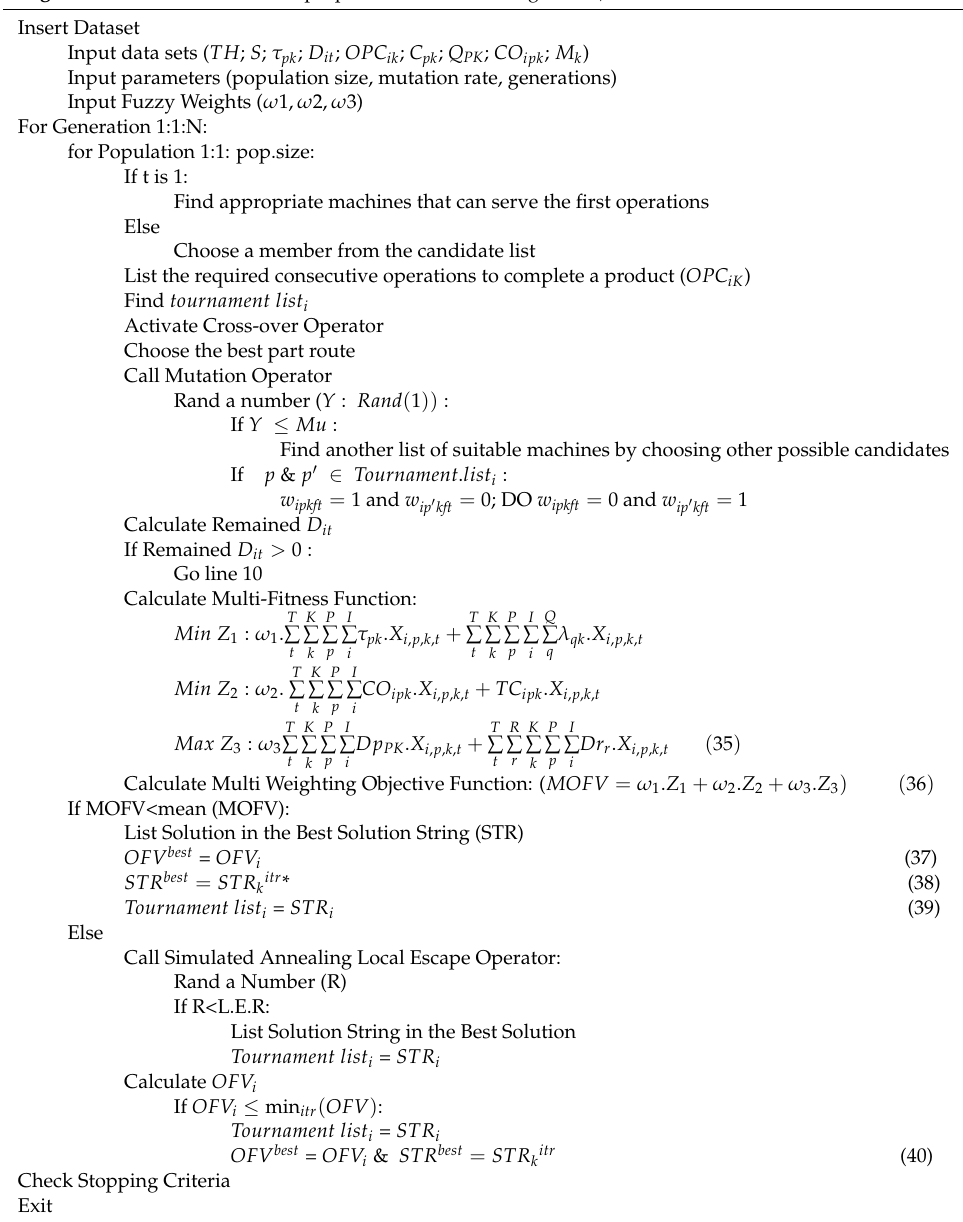
Algorithm 1 Pseudo code of the proposed FW-NSGA-II